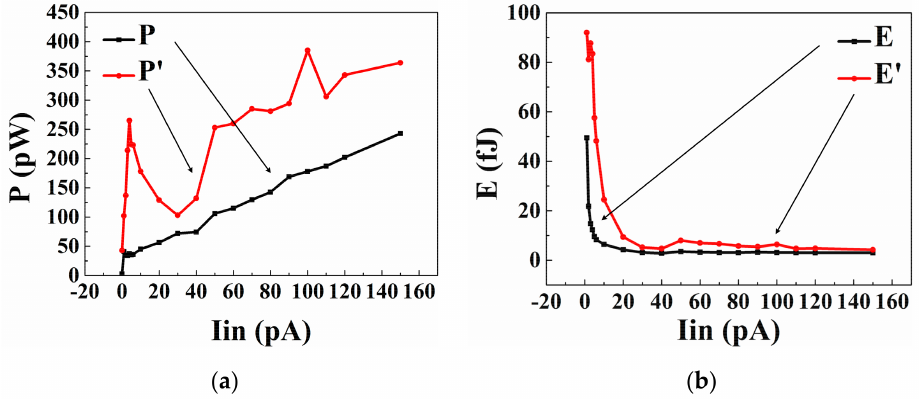
Figure 10. The comparison of power and spike energy between the artificial neurons using the tail current source in M2 and M2 (cid:48) . ( a ) P is the power of the circuit with M2. P’ is the power of the circuit with M2 (cid:48) . ( b ) E is the spike energy of the circuit with M2. E’ is the spike energy of the circuit with M2 (cid:48)